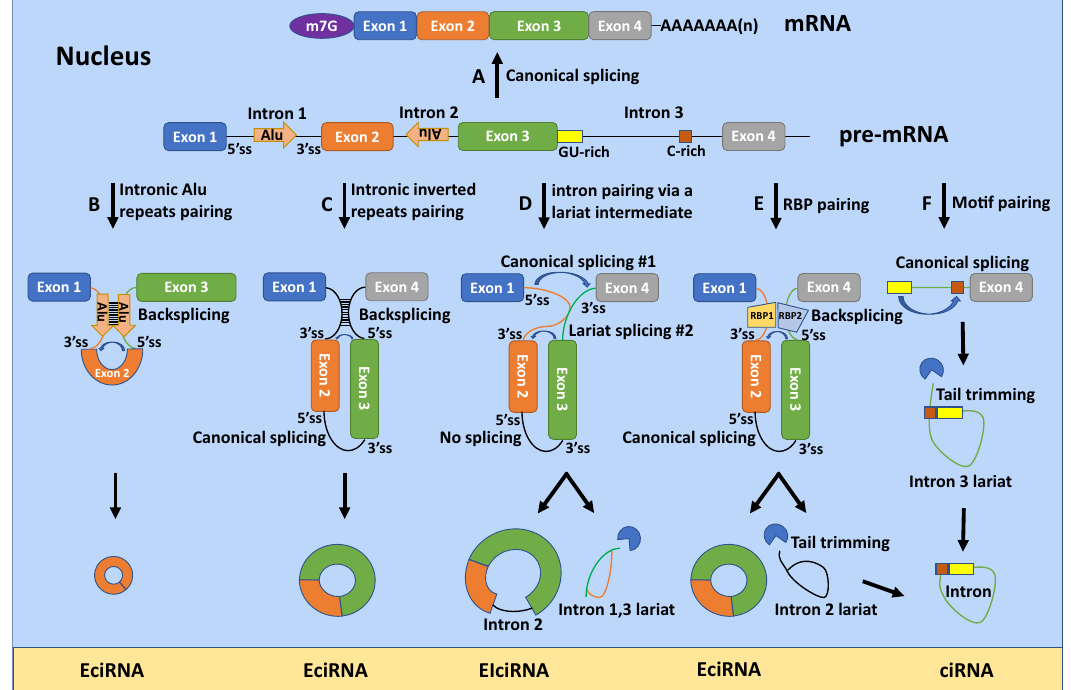
Fig. 1 Biogenesis of circRNA types. Canonical splicing generates a mature mRNA from a pre-mRNA ( A ). CircRNAs are generated from exons, introns, or both exons and introns. Exonic circRNAs (EciRNAs) are formed when fl anking introns bridged by the pairing of reverse complementary sequences or by RNA binding proteins undergo backsplicing (5 ′ splice site is covalently linked to 3 ′ splice site) ( B ) or backsplicing in combination with canonical splicing ( C , E ). Exo-intronic circRNAs (EIciRNAs) are formed when introns are retained ( D ). Intronic circRNAs (ciRNAs) are derived from an intron that is excised from a pre-mRNA by canonical splicing when a 7-nt GU rich element at the 5 ′ ss and an 11-nt C-rich element near the branchpoint site pair to form a lariat intron that evades canonical debranching and exonucleolytic degradation. The 3 ′ tail downstream from the branchpoint is then trimmed, resulting in a circular RNA ( F